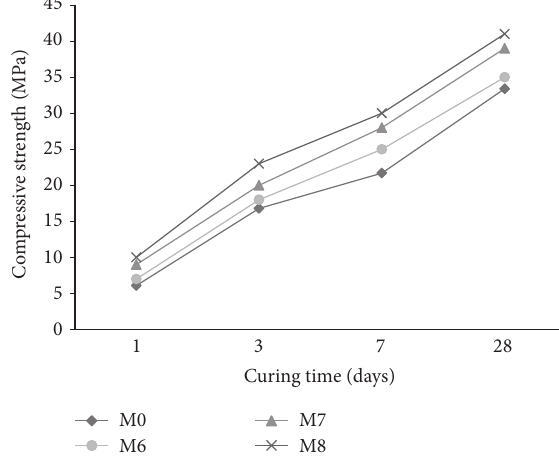
Figure 10: The effect of copolymer latexes prepared in presence of DBSS/POE on the compressive strength of